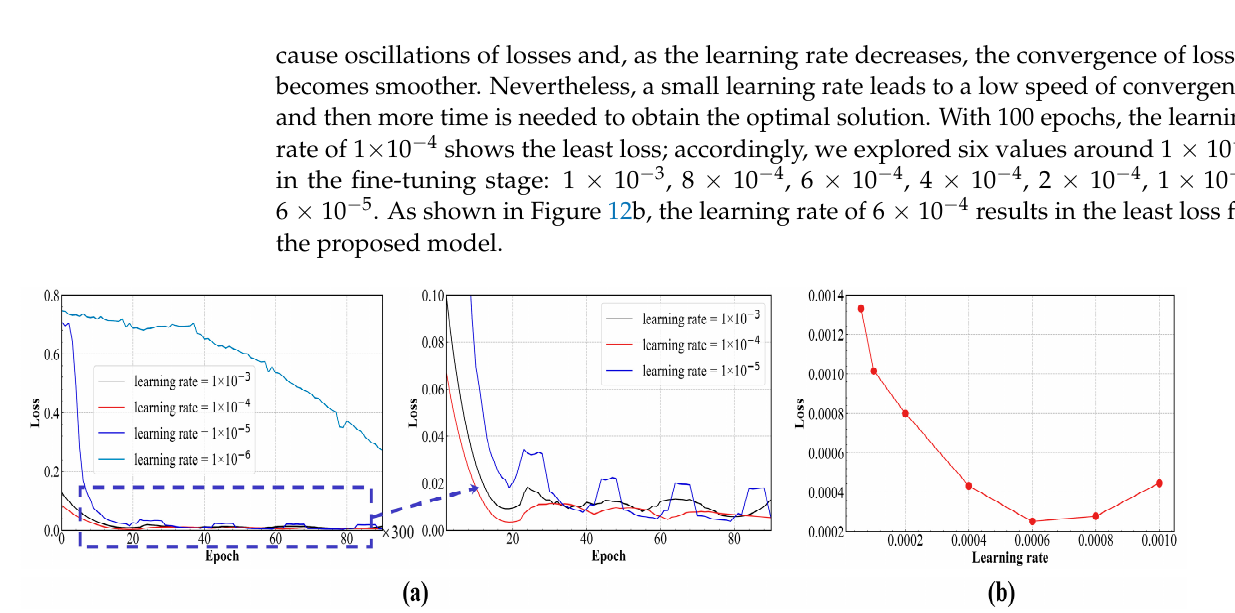
14 of 17 Figure 11. Convergence history of the network models with different numbers of network layers. 3.2.3. Influence of Learning Rate The learning rate is one of the most important hyperparameters affecting the perfor- mance of the network model. The value of the learning rate represents the speed at which the weight of the network is updated. Although a small learning rate can ensure that the